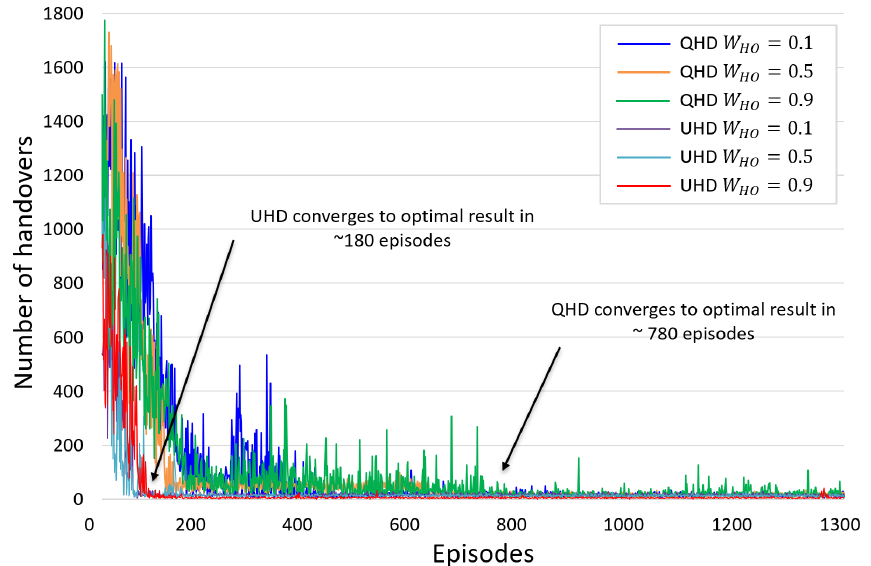
Figure 5. Convergence rate comparison between UHD and QHD methods with handover weight ( W HO ) values 0.1, 0.5, and 0.9.